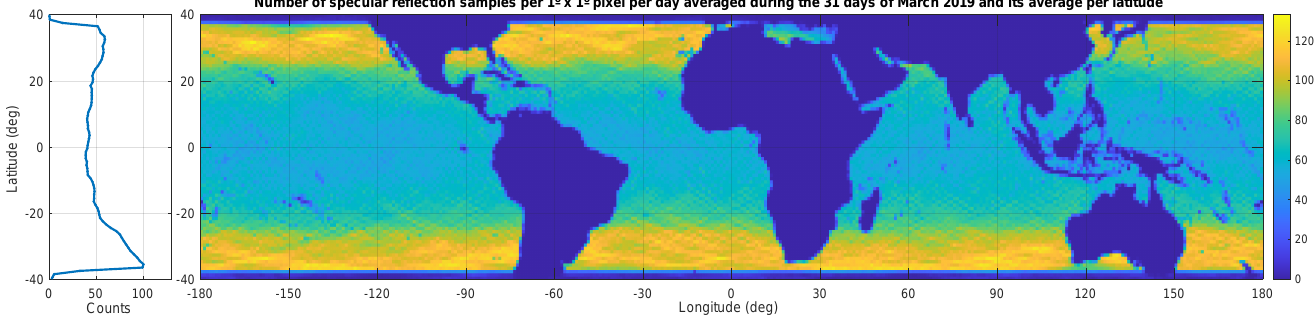
Figure 1. Map showing the average number of DDM samples per 1 ◦ × 1 ◦ pixel per day, after filtering the land cover. The average is computed during the whole month of March 2019. On the left plot the computed average number of DDMs per latitude is